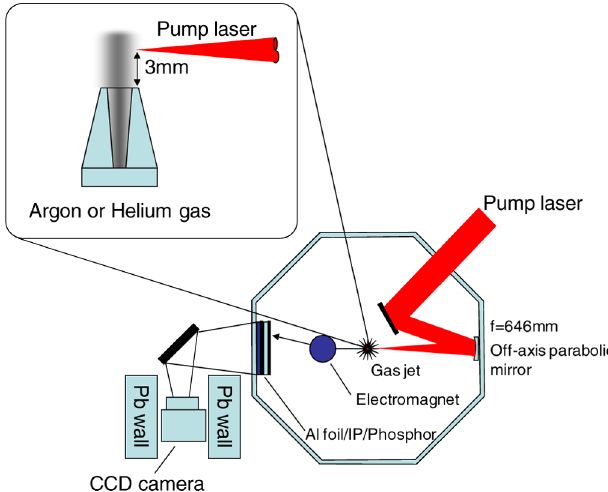
FIG. 1. (Color) Schematic diagram of the experimental